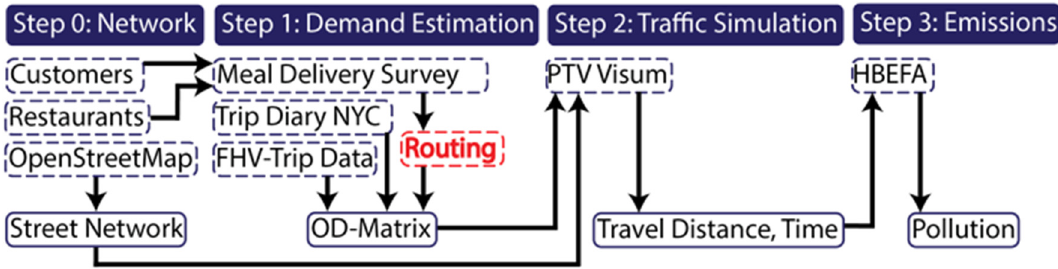
Figure 2. Study methodology (On-demand meal delivery–tour based